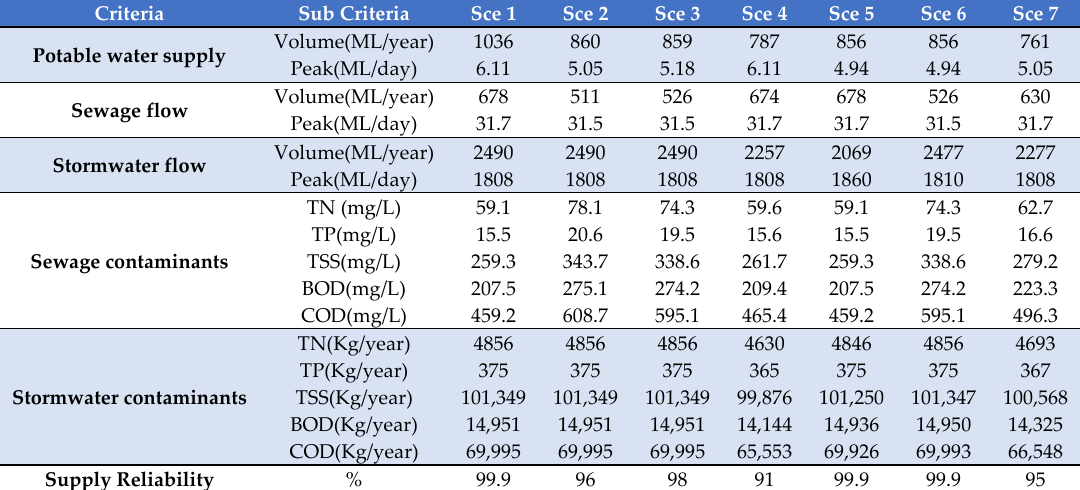
Table 1. Input Evaluation Matrix for PROMETHEE.